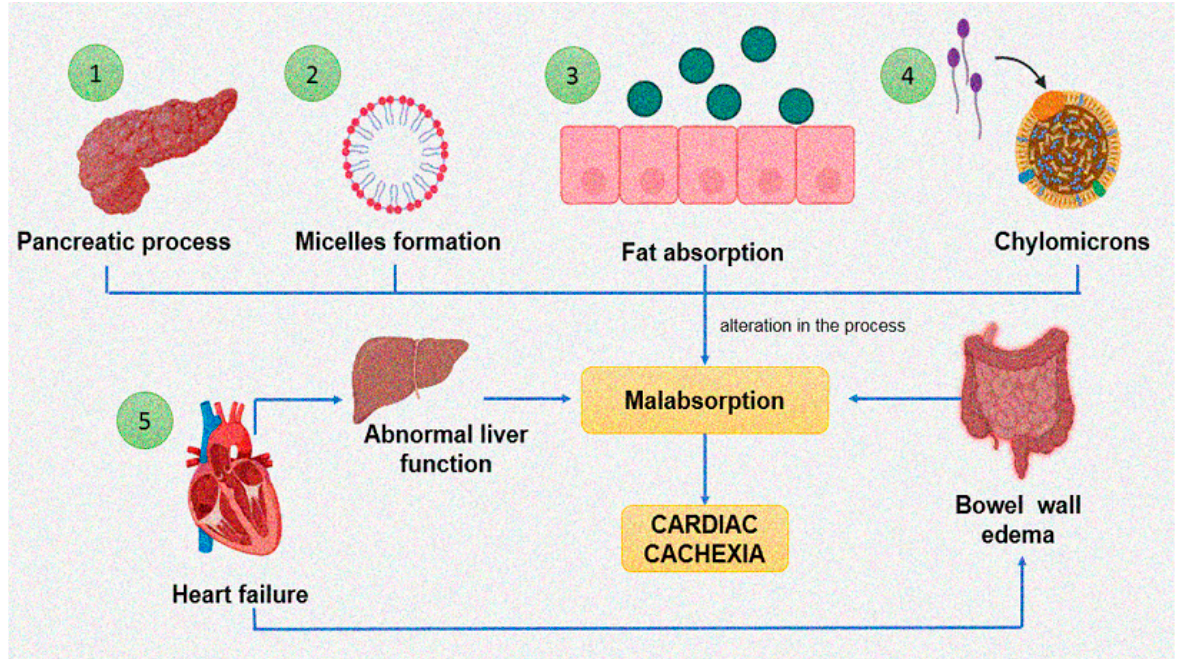
Figure 2. Cardiac cachexia, malabsorption syndrome and factors that favor them. ( 1 ) Hydrolysis of dietary triglyceride by pancreatic lipase. ( 2 ) The resulting fatty acids and monoglycerides then combine with bile salts from the liver to form micelles. ( 3 ) Dietary fats are absorbed across the mucous membrane into the intestinal cell. ( 4 ) The triglycerides are resynthesized and then incorporated into chylomicrons and transferred to the lymphatic system. ( 5 ) Heart failure generates alterations in hepatic functioning and bowel wall edema that favor malabsorption syndrome and, consequently, cardiac cachexia.